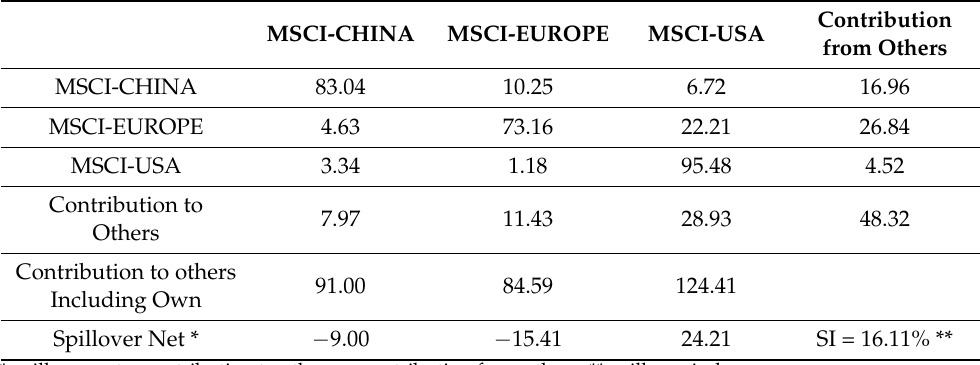
Table 5. Volatility spillover index (during-crisis